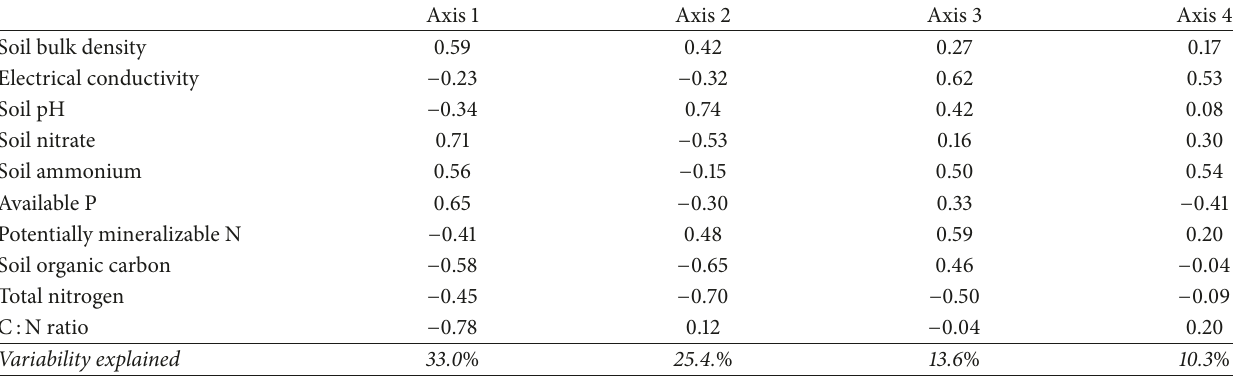
Table 2: Principal component scores of measured variables and proportion of variability explained within each axis for data group 1 (S1).